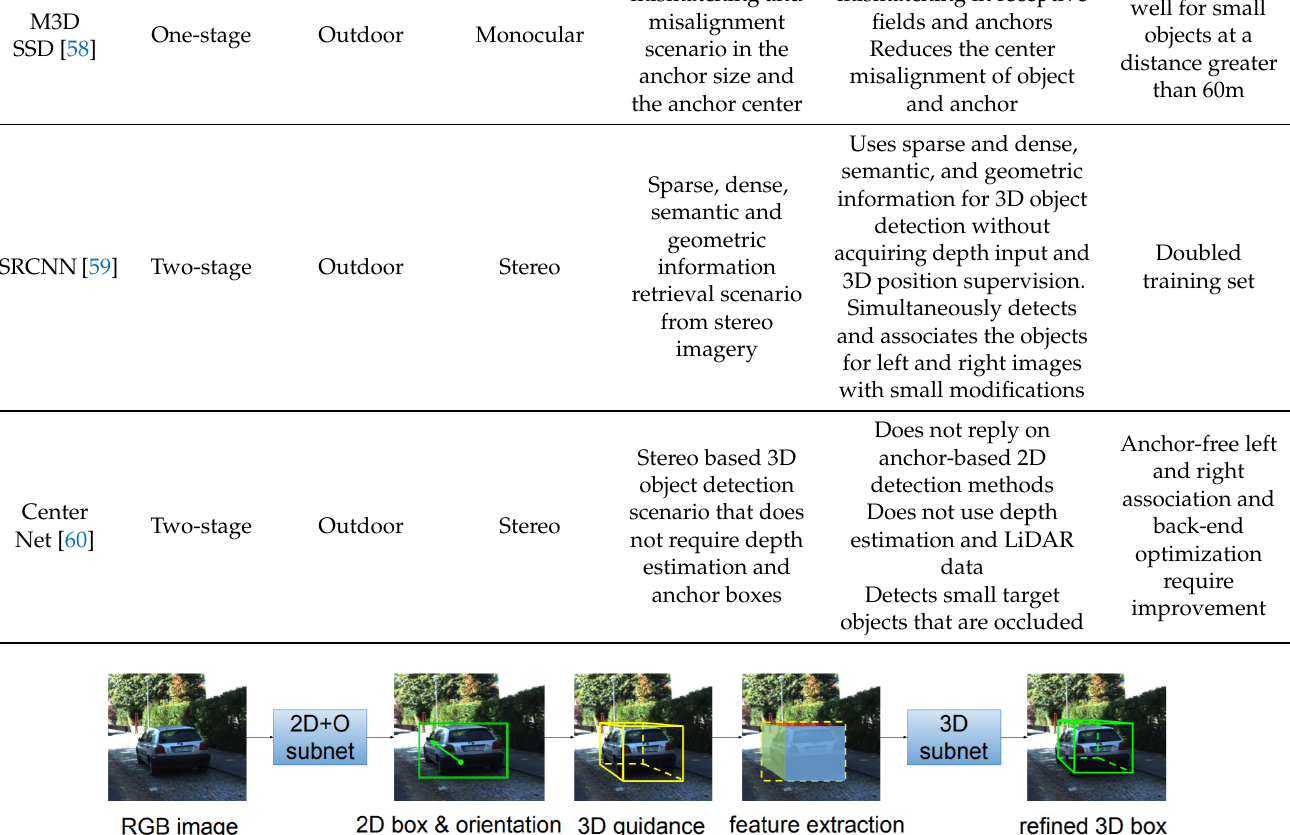
Figure 6. The proposed 3D object detection paradigm [56] consisting of a CNN based model (2D+O subnet), 3D guidance generated using the obtained output of 2D+O subnet, and extracted features utilized by the refinement model (3D